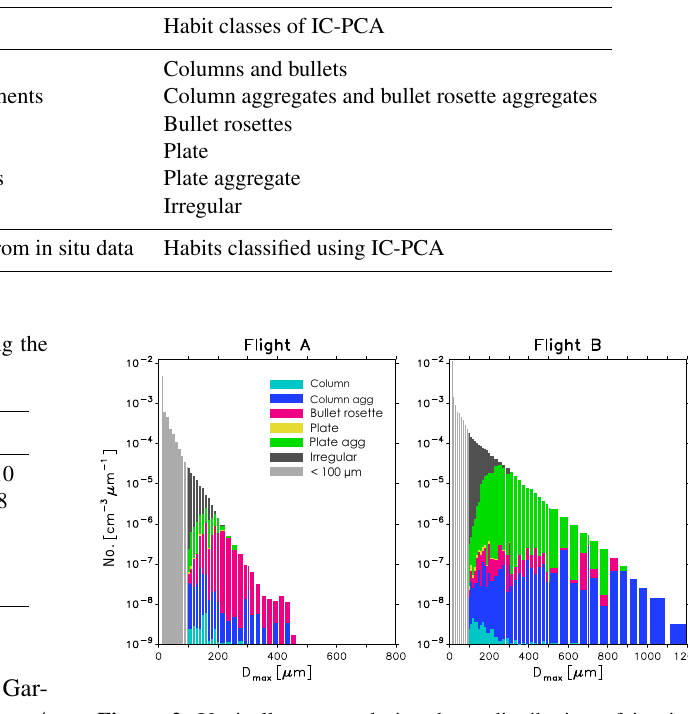
Figure 2. Vertically averaged size-shape distribution of in situ- measured ice crystals during the flights on 23 March 2010 (flight A) and 24 June 2010 (flight B). These distributions were obtained by weighting fractional habit distributions at each vertical layer by the corresponding particle size distribution. The height of each col- umn indicates the total number of particles in each size range (log- arithmic scale on the y axis). The fraction of particles of each habit is shown with different colors (on a linear scale). Small ice crys- tals with D max < 100µm are shown in gray. They were treated as columns in the